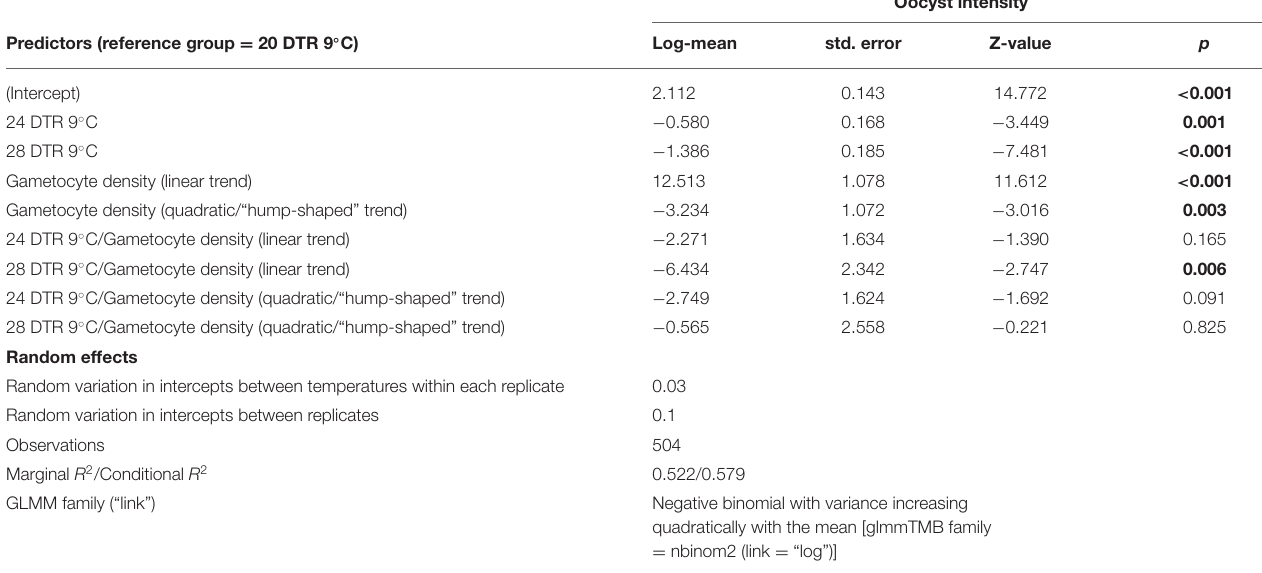
TABLE 2 | Statistical models for oocyst intensity (infected